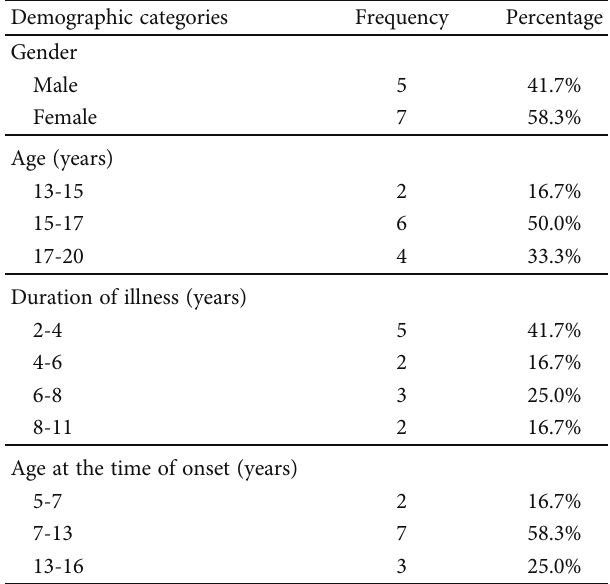
Table 1: Participant